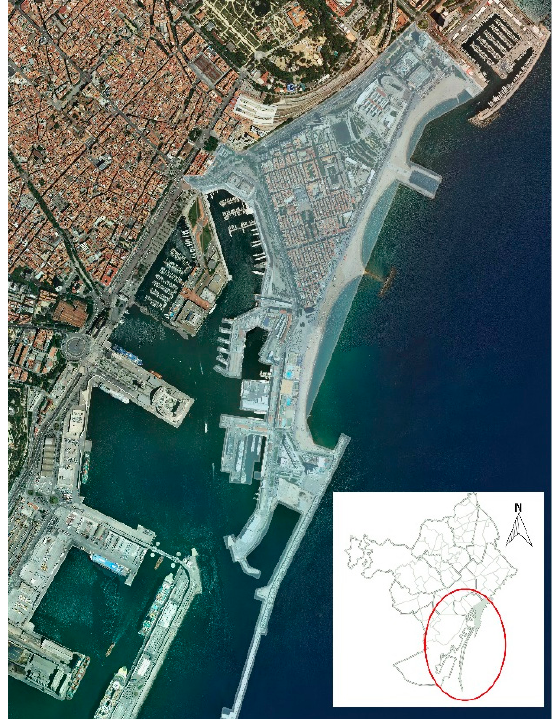
Figure 9. Location of the Barceloneta neighborhood.